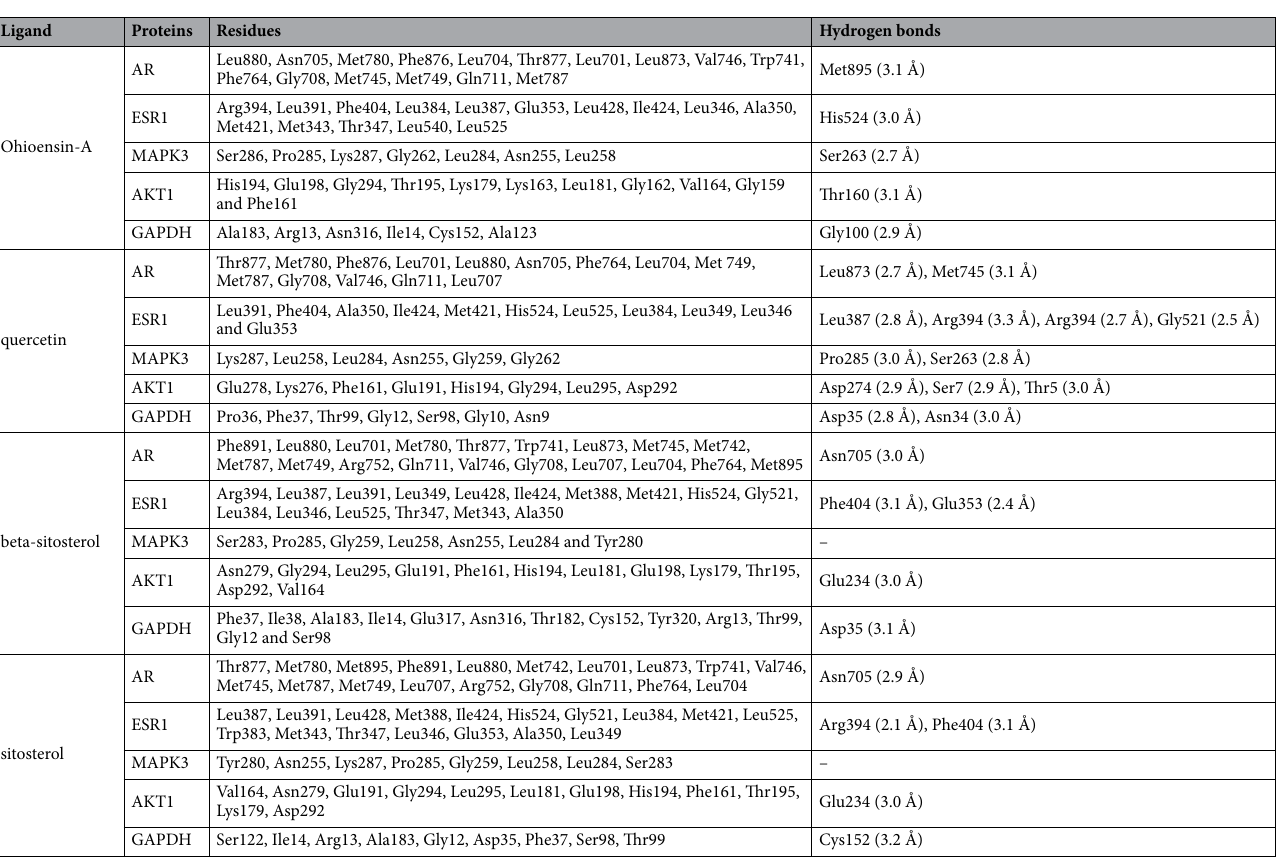
Table 2. Results of molecular docking between the bioactive components and the core predicted targets.